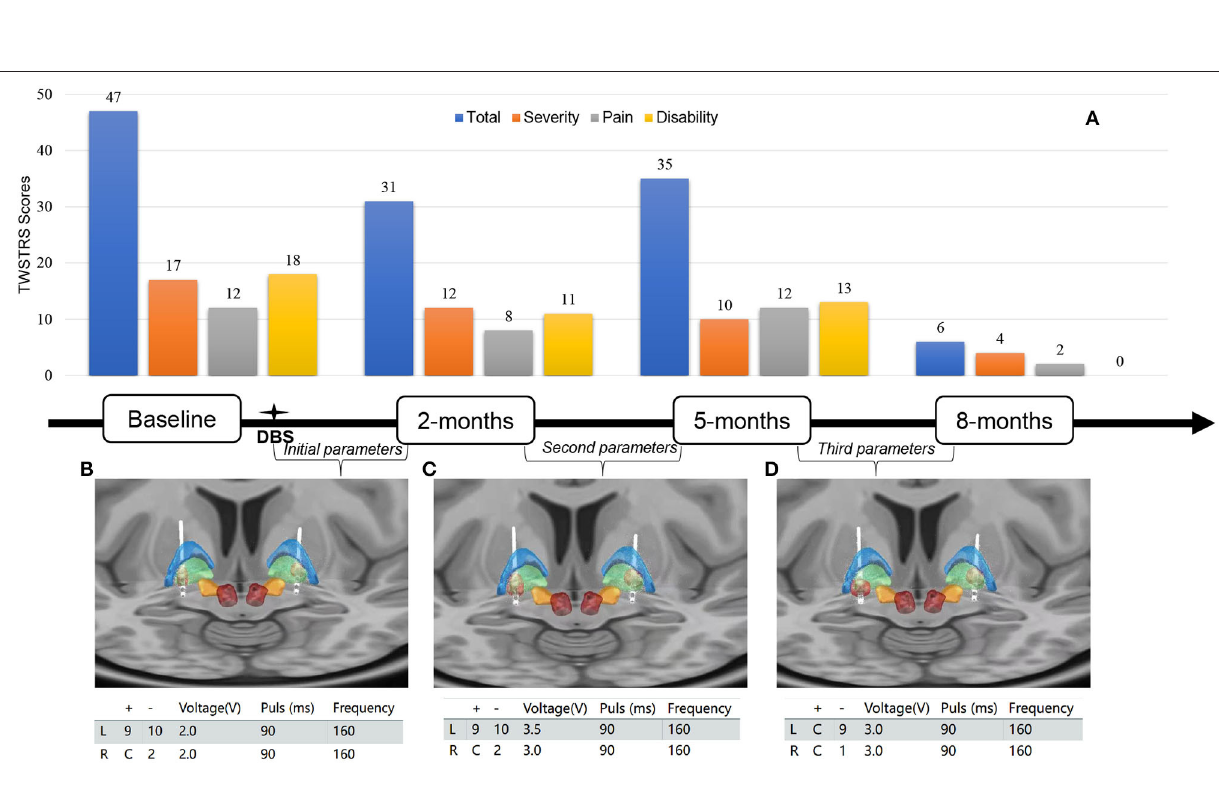
Frontiers in Neurology |